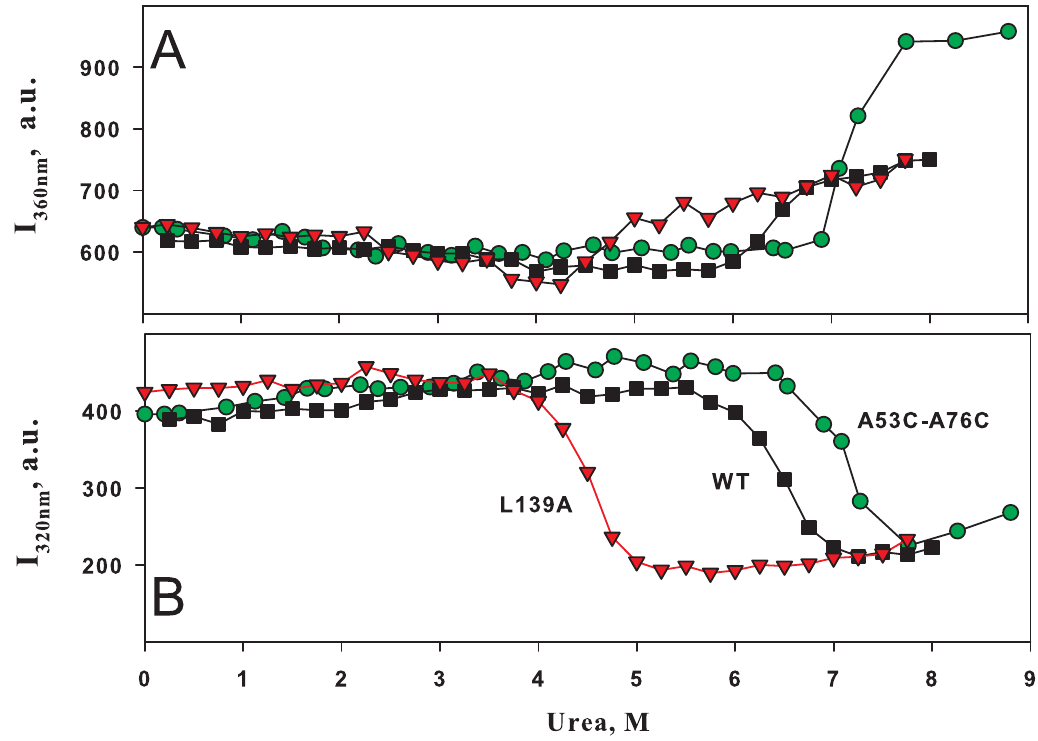
Fig 1. Effect of urea on fluorescence intensity of BCA II. Dependence of fluorescence intensity I at 360 nm (A) and 320 nm (B) on urea concentration for wild-type BCA II ( ■ WT) and its two mutant forms ( ▼ L139A and ● A53C-A76C). Excitation at 280 nm. The vertical line at 7 M is a reference to compare the curves (see the